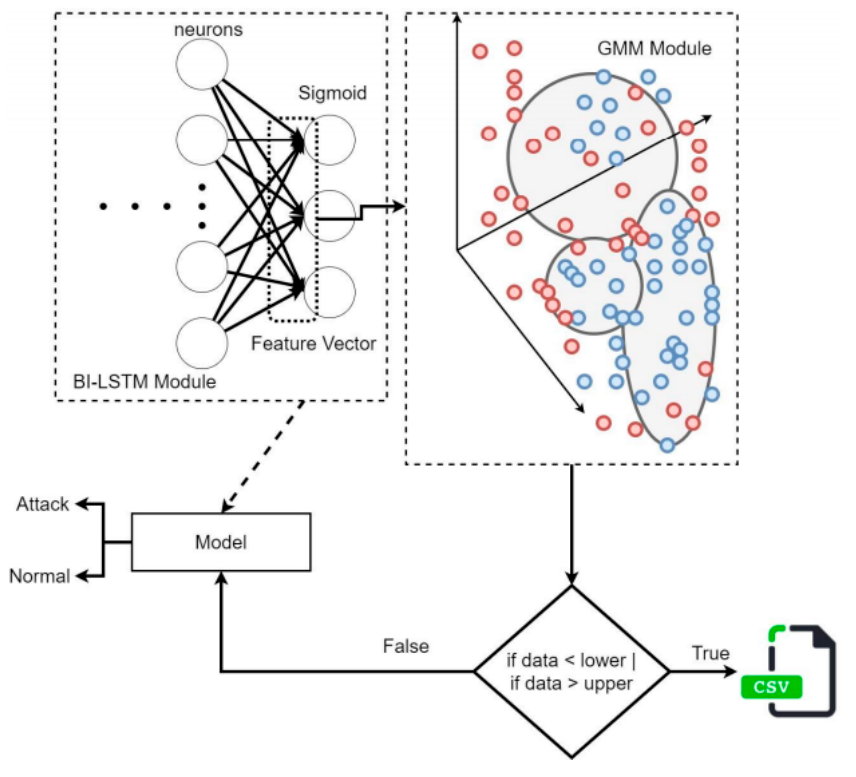
Figure 5. The control flow of the GMM module.